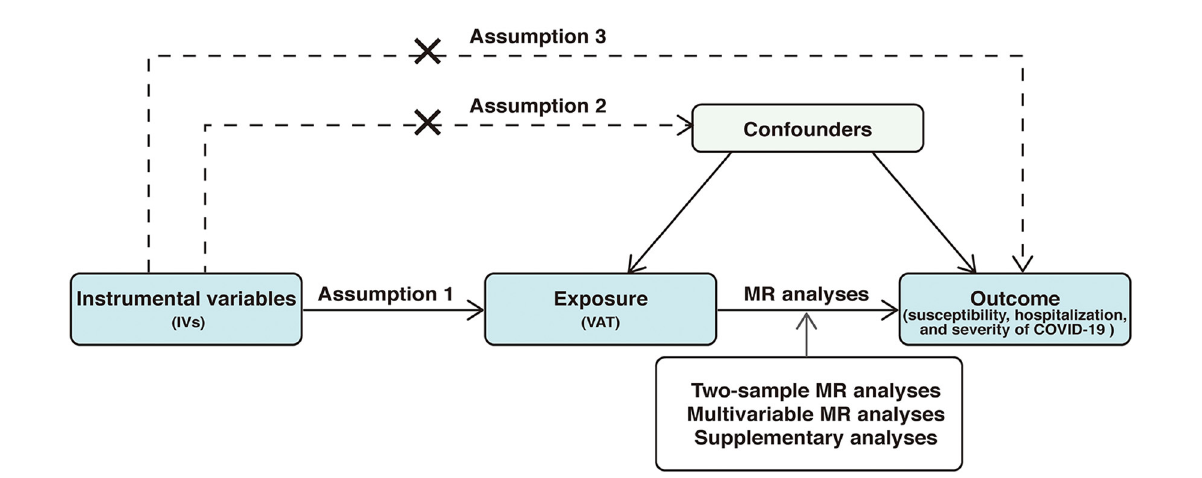
FIGURE1 Overview of the study design. The study was based on 3 important assumptions: 1, genetic variants selected as instrumental variables (IVs) should be significantly associated with the exposure (VAT), 2, IVs should not be associated with any confounders, and 3, IVs should not affect the